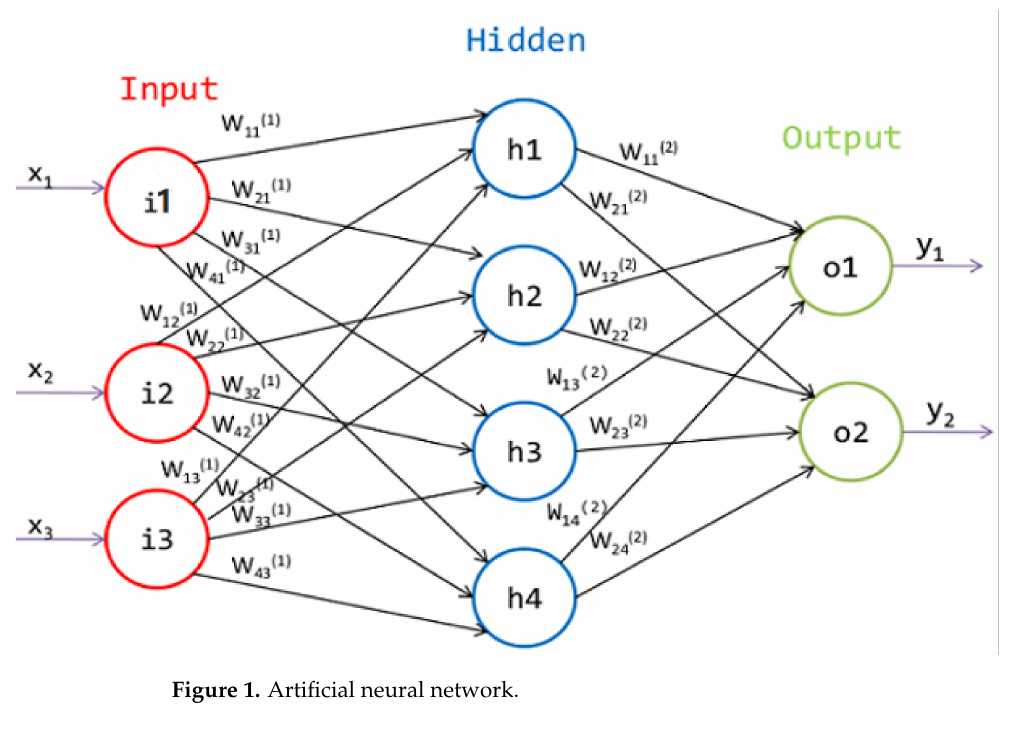
Figure 1. Artificial neural network.